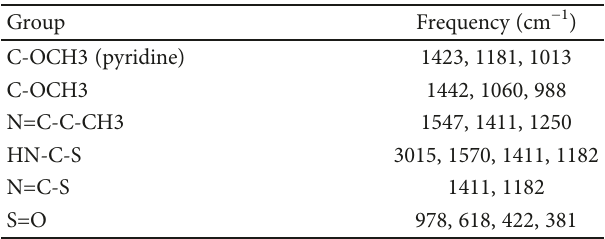
Table 3: Calculated stretching and deformation modes of OMP polar groups.